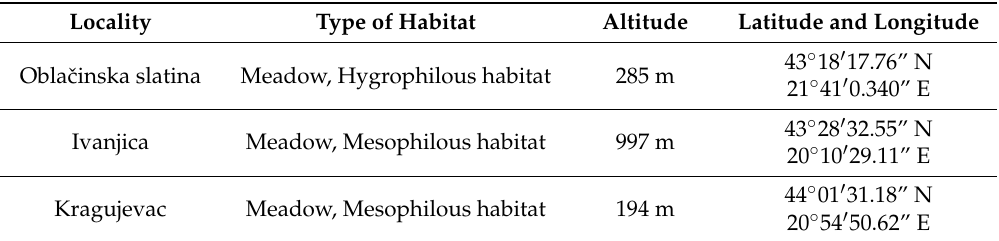
Table 3. The basic characteristics of the localities in which the species C. intybus was